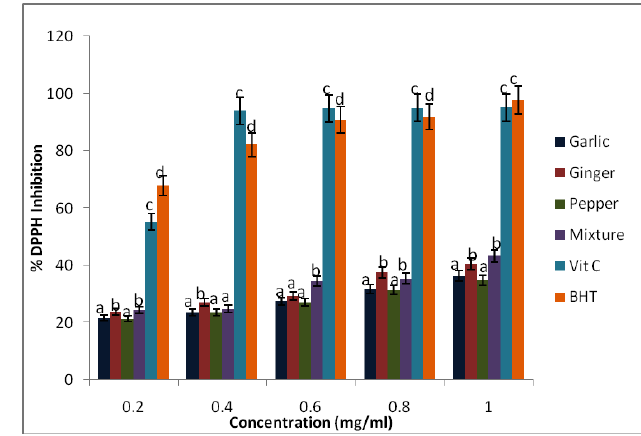
Fig. 2: DPPH radical scavenging activities of garlic, ginger, pepper and their mixture. a-d Values are means of 3 determinations ± SEM. Bars with different colours carrying different letters are significantly different (P<0.05).